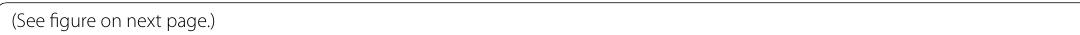
Fig. 4 PGC-1α steady over-expression in MERRF cybrids. Wt-cybrids and H-cybrids were transduced with either an empty or a PGC-1α expressing lentiviral vector and then puromycin-selected to generate steady over-expressing PGC-1α cybrids lines. A PGC-1α gene expression was evaluated by qPCR. ACTIN was used as reference gene. B Western blot of PGC-1α; ACTIN was used as loading control. A representative blot of three independent experiments (biological replicates) is shown. C Densitometry of PGC-1α protein content, normalized to the cybrids transduced with the empty plasmid. D ND1, E COX2 and F ATP6 gene expression evaluated by qPCR. ACTIN was used as reference gene. Data are means and SEM of three biological replicate and are normalized to the cells transduced with the empty plasmid. G Western Blot of OXPHOS subunits and of TOM20, VDAC e TFAM protein. ACTIN was used ad loading control. One representative of three independent experiment (biological replicates) is shown. H Densitometric analysis of OXPHOS subunits protein level. Data, normalized to the cybrids transduced with the empty plasmid, are means and SEM of six independent experiments (biological replicates). I Densitometric analysis of TOM20, VDAC and TFAM mitochondrial mass proteins. Data are means and SEM of three independent experiments (biological replicates) and are normalized to the cells transduced with the empty plasmid. J mtDNA content evaluation by qPCR. All data are means SEM of six biological replicates and are normalized to the empty cells. K m.8344A > G + mutation heteroplasmy evaluation by snapshot method. Values are expressed as means and SEM of three biological replicates. L OCR expressed as pmoles O 2 /min normalized for protein content, under basal conditions and after injection of oligomycin (O), carbonyl cyanide 4-(trifluoromethoxy) phenylhydrazone (FCCP; F), rotenone (R) and antimycin A (AA). Data are means SEM of three independent experiments (biological replicates). ± M Basal, ATP-linked and maximal respiration were calculated from OCR traces and reported in the graph. All values are means and SEM of three independent experiments (biological replicates). Statistical analyses were performed using unpaired two-tail T-test. P value: *p < 0.05, **p < 0.01, ***p